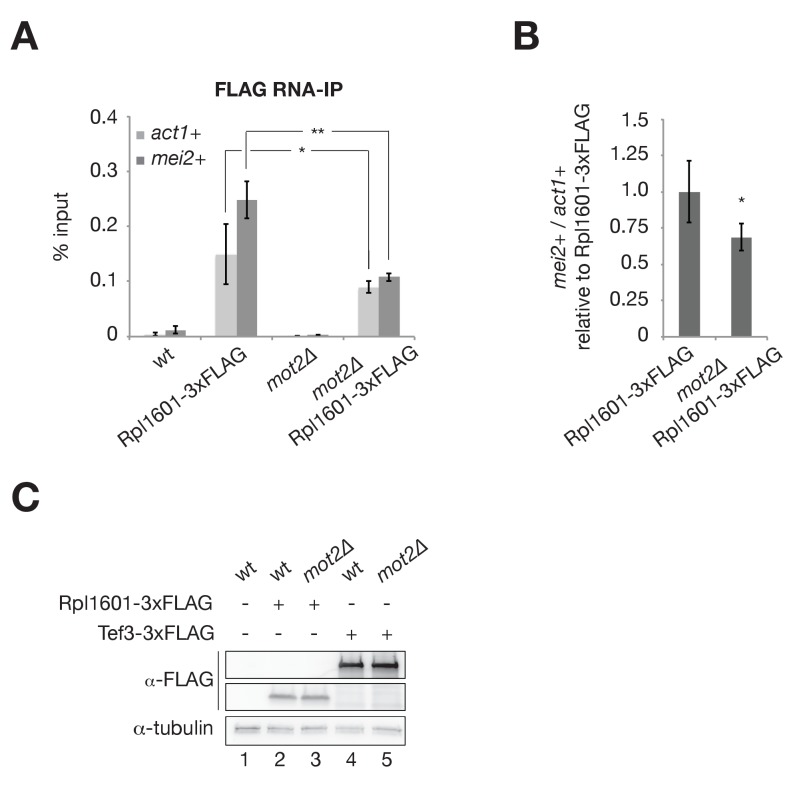
Mot2 does not repress mei2+ mRNA translation.(A) RNA-immunoprecipitation experiments in wild type and mot2∆ cells. Shown are the enrichments (% input) of act1+ and mei2+ mRNAs upon pulldown of the 3xFLAG-tagged 60S ribosomal subunit Rpl1601. Error bars represent the standard deviation of six independent immunoprecipitations from at least three biological replicates. Stars denote statistical significance between samples (t-test p-values: act1+ = 4.29E-2; mei2+ = 1.08E-4). (B) Quantification of mei2+ mRNA levels normalized to act1+ transcripts and expressed relative to the wild type tagged strain (Rpl1601-3xFLAG). Error bars represent the standard deviation of six independent immunoprecipitations from at least three biological replicates. The star denotes statistical significance between samples (t-test p-value=1.39E-2). (C) Western blot showing that total levels of Rpl1601 and Tef3 are not affected by the deletion of mot2+. 3xFLAG-tagged proteins were detected with an anti-FLAG antibody and an anti-tubulin antibody was used as a loading control.